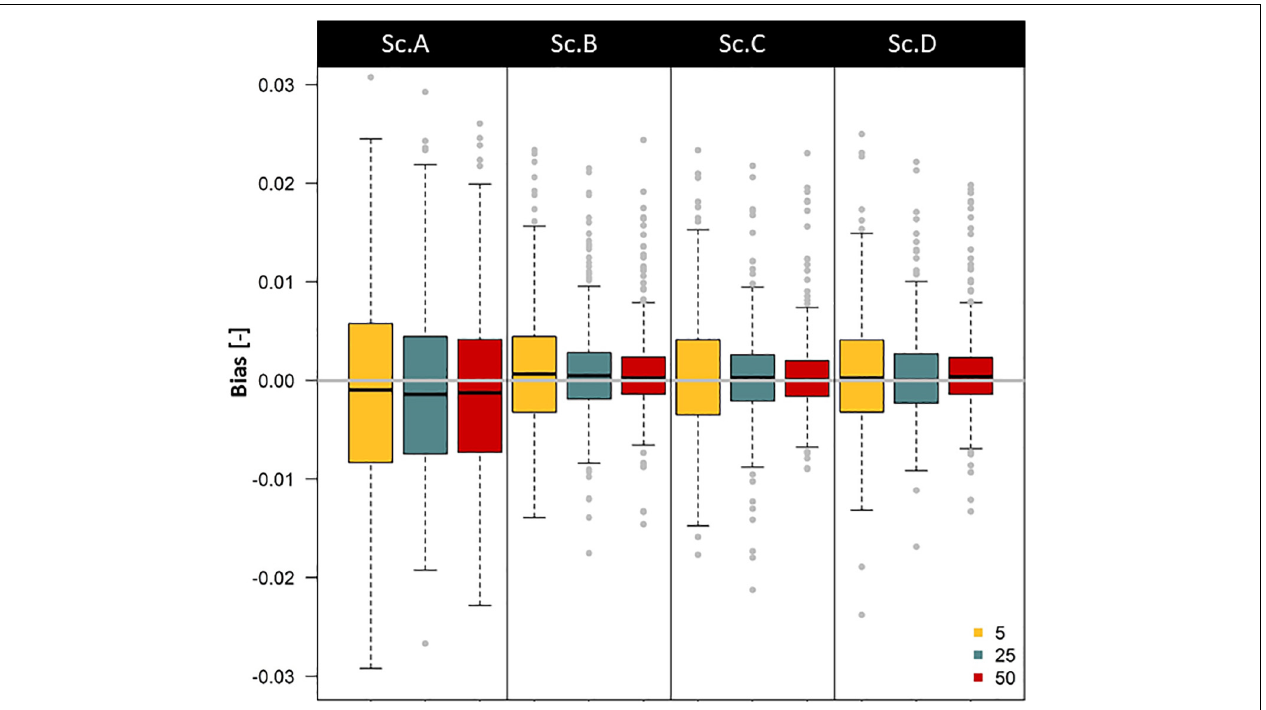
FIGURE 3 | Boxplots showing the expected bias in β estimation ( b β ) for four theoretical scenarios, bias decreases when key biophysical parameters ( χ ) are known or when the sample size increases. Sc. A: No variable range restrictions are considered. Sc. B: Restriction imposed on the physical variables, i.e., the soil heterogeneity. Sc. C: Restriction of both the physical variables and the sampling strategy. Sc. D: Full restriction, thus considering an additional restriction on the biological plant-specific variables. Different boxplots’ colors show the considered sample size (5: yellow, 25: blue, 50: red). Boxplots show Q25 - 1.5 IQR, Q25, Q50, Q75 and Q75 + 1.5 IQR values, with IQR the interquartile range. Outliers are provided as gray